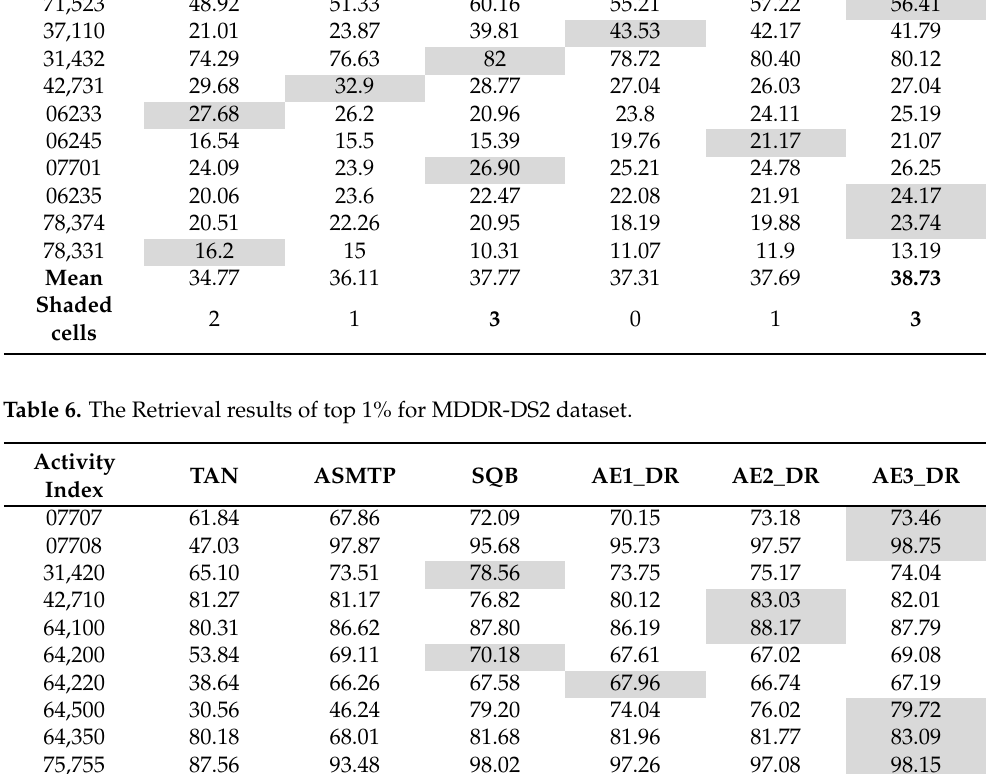
Table 5. The Retrieval results of top 5% for MDDR-DS1 dataset.